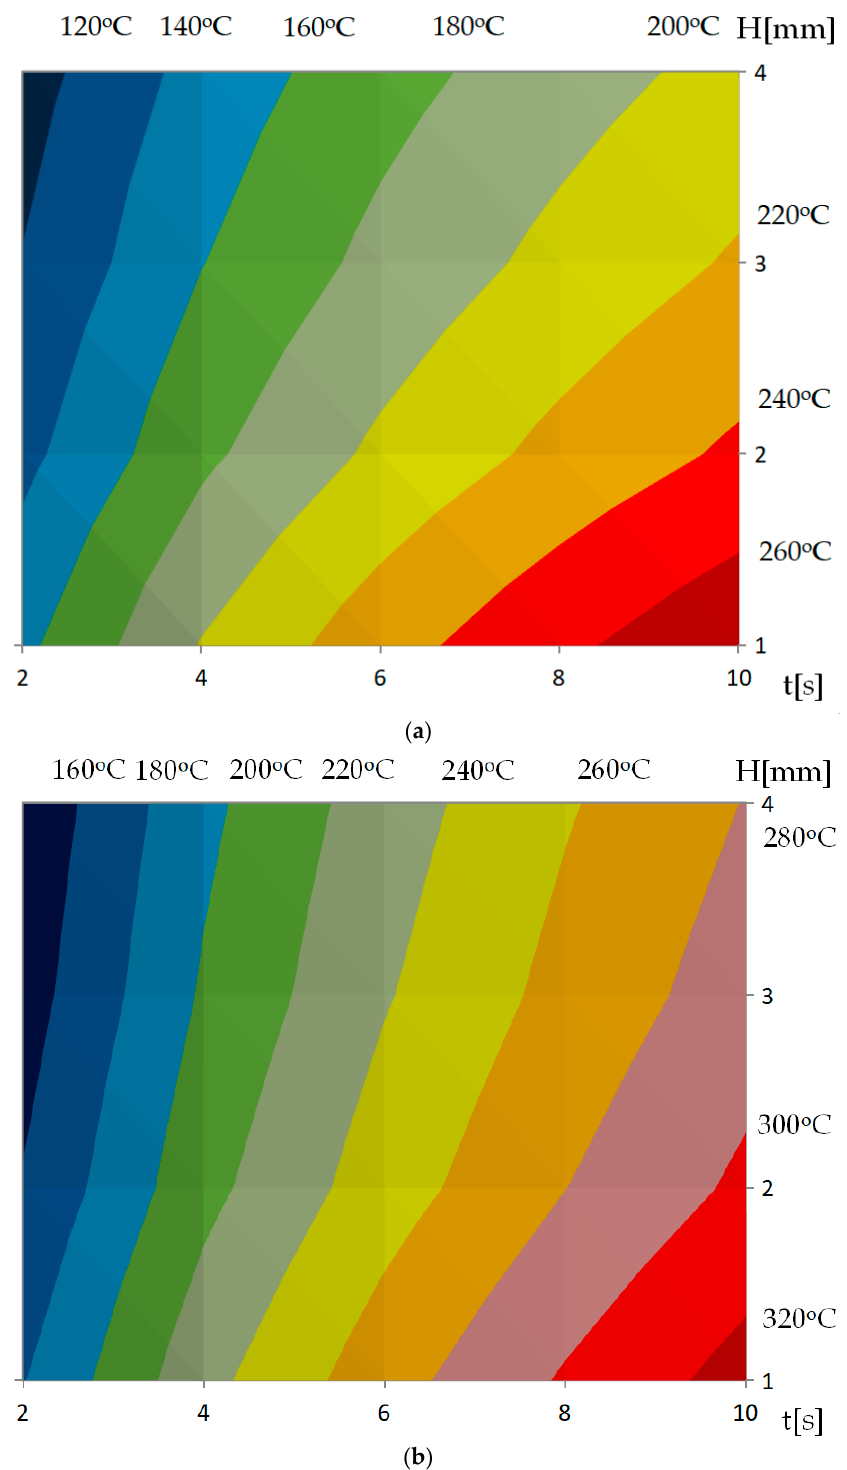
Figure 10. Temperature at point A (center of the cavity surface) in the function of time t for different distances between mold and inductor (equal to maximum surface temperature) and for ( a ) P2, ( b ) P3.